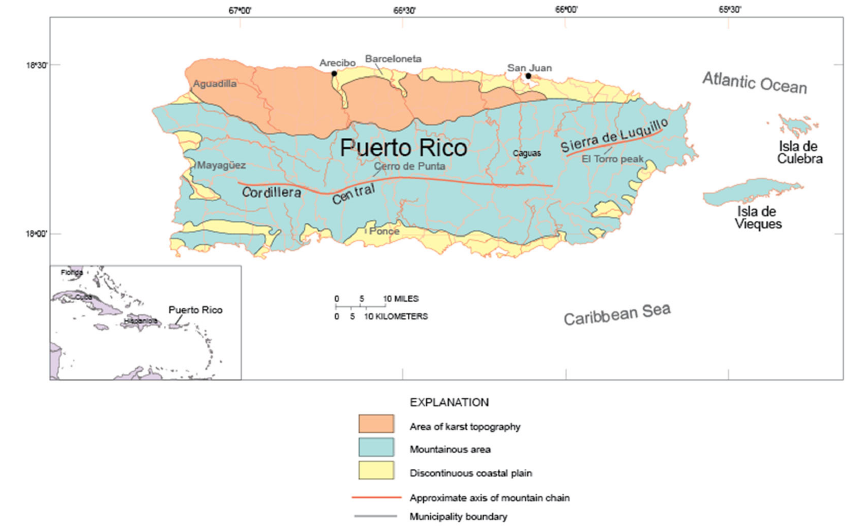
Figure 1. Map showing the study area, Puerto Rico.